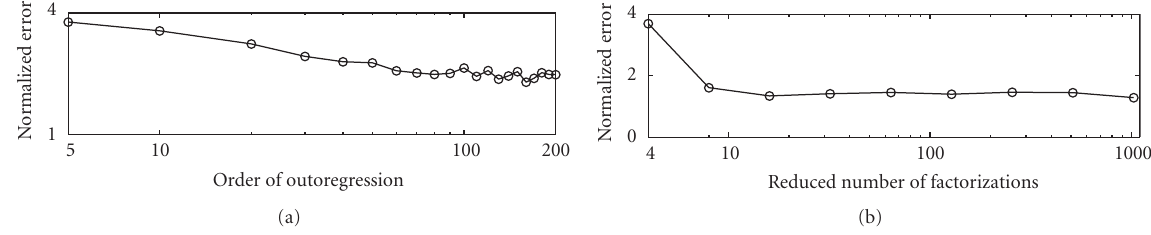
Figure 17: Normalized average errors of simulated samples using AR filter (a) and POD-based technique (b) by increasing the order of autoregression (AR filter) and the reduced number of factorizations (POD-based method).